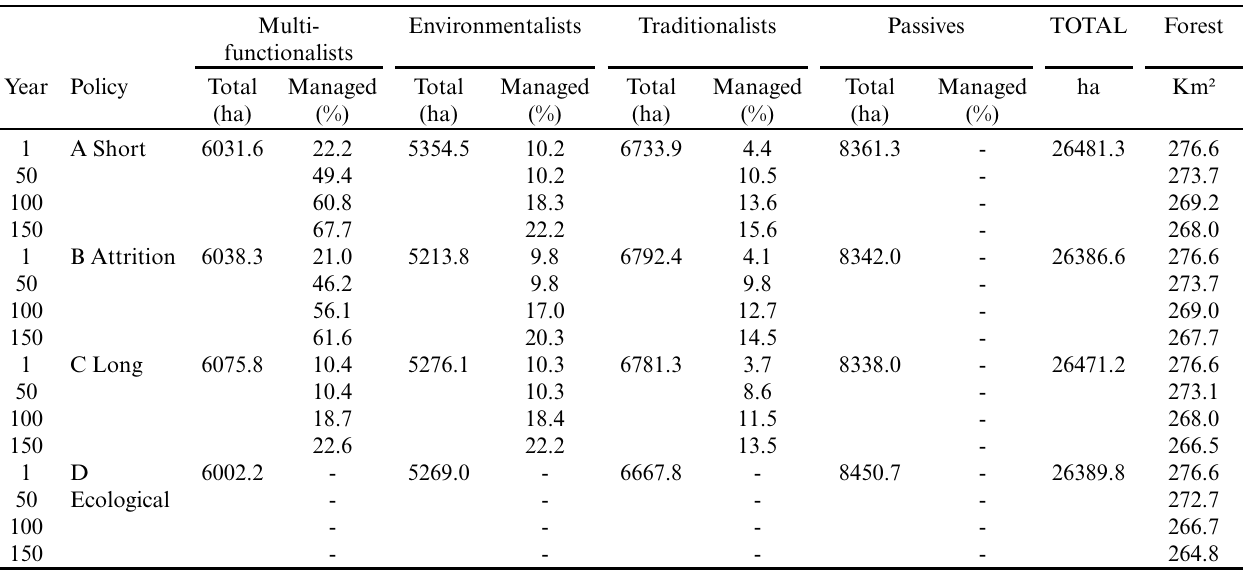
Table 4 . Distribution of ha by forest owner category and policy scenario. average of 100 runs.